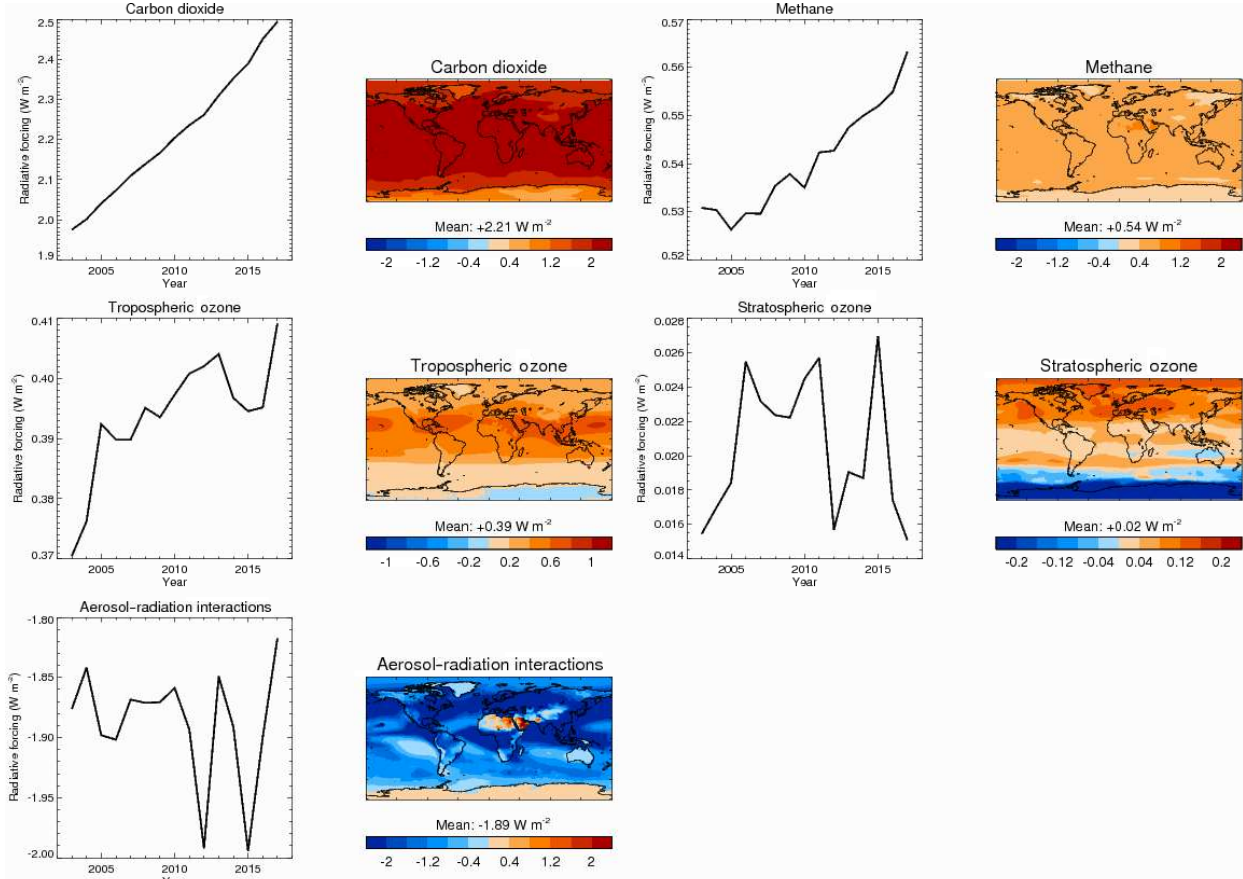
Figure 11. As in Fig. 10 but for cloud-free conditions. Note that radiative forcing of aerosol–cloud interactions is undefined in the absence of clouds, so is not shown here.